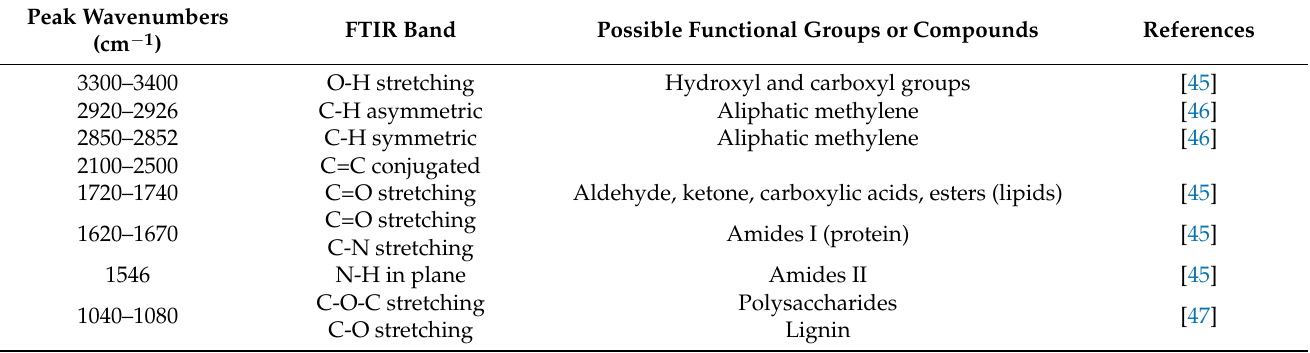
Table 5. FTIR frequency ranges and functional groups in raw POME and POME after DBD treatment under non-aerated and aerated